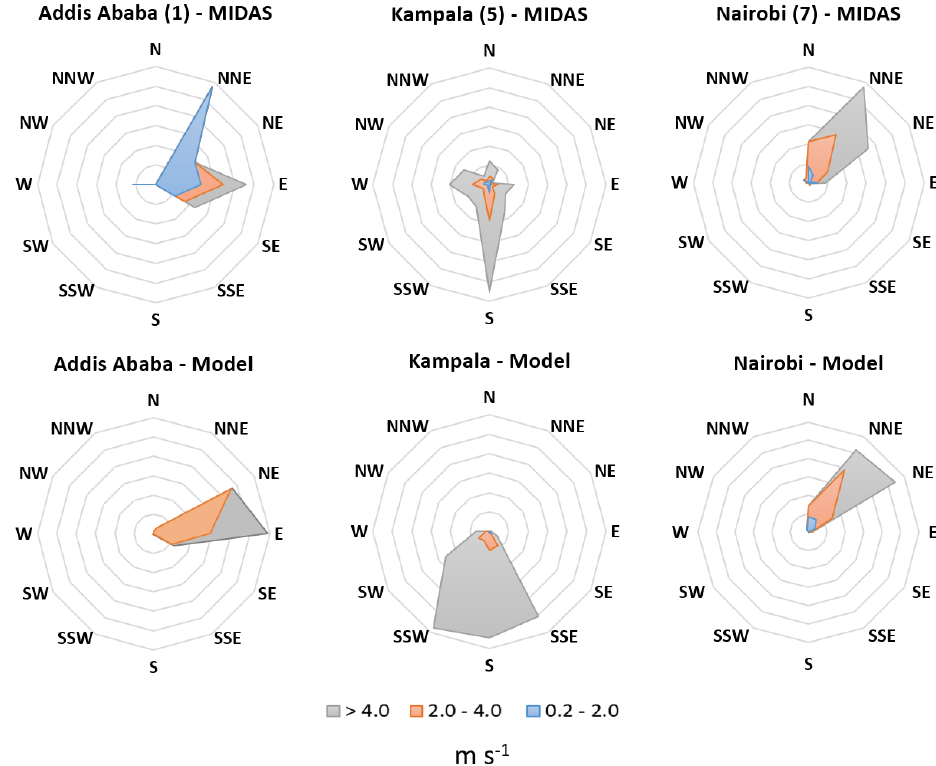
Figure 5. Averaged wind roses for the whole analysis period (14 February to 14 March 2017) from the closest ground weather stations to the urban centres of Nairobi (station no. 7 in Fig. 2c), Kampala (station no. 5 in Fig. 2b), and Addis Ababa (station no. 1 in Fig. 2a) (MIDAS observations, top row) and from WRF simulations (model outputs, bottom